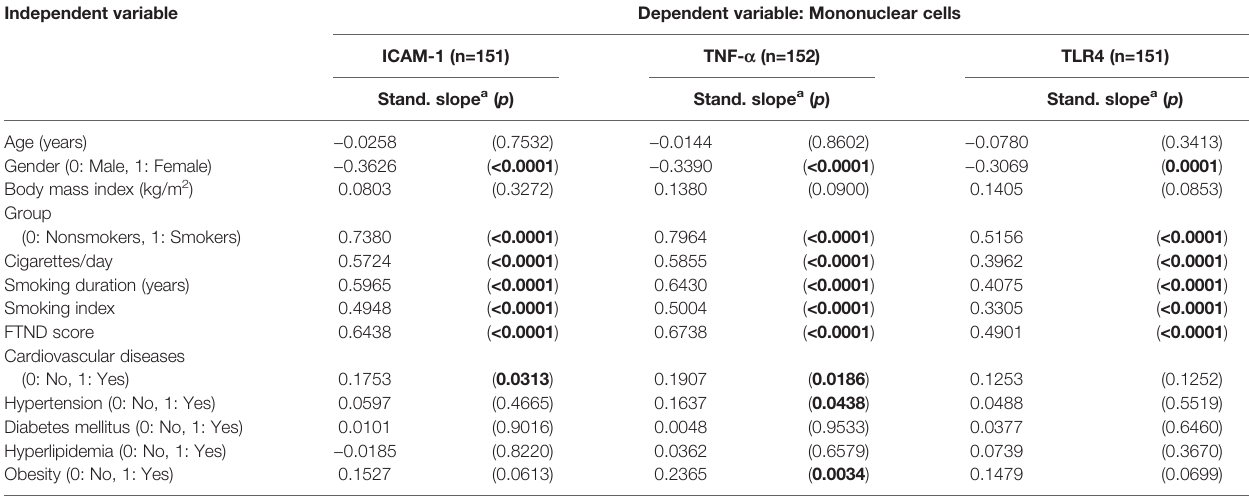
TABLE 3 | Simple linear regression analysis for mononuclear cell markers (n = 159). Independent